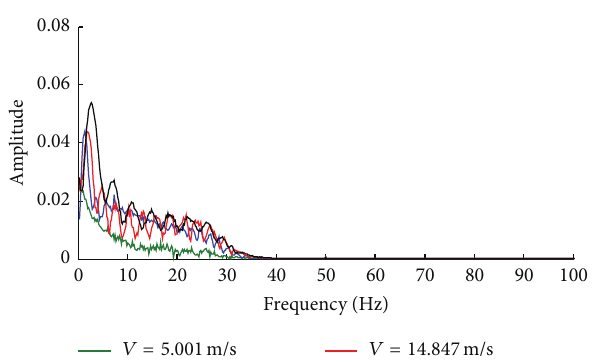
Figure 5: FFT spectrum of some signals.